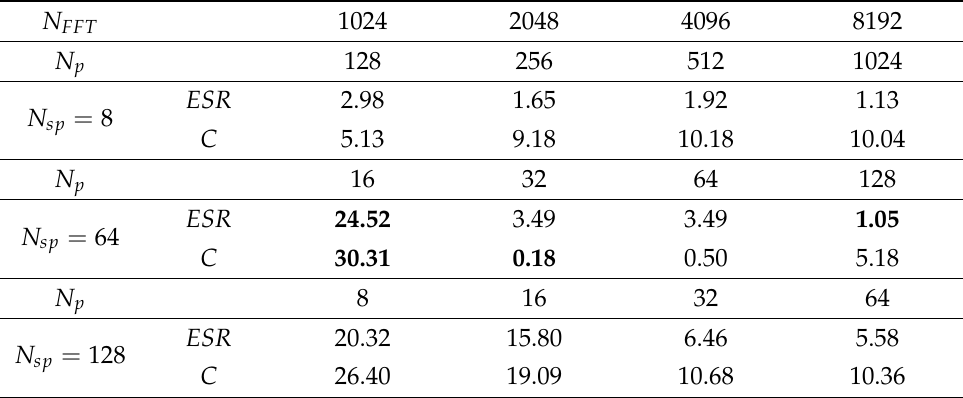
Table 8. Percentage error estimating C and ESR with A d = 5% of the nominal duty